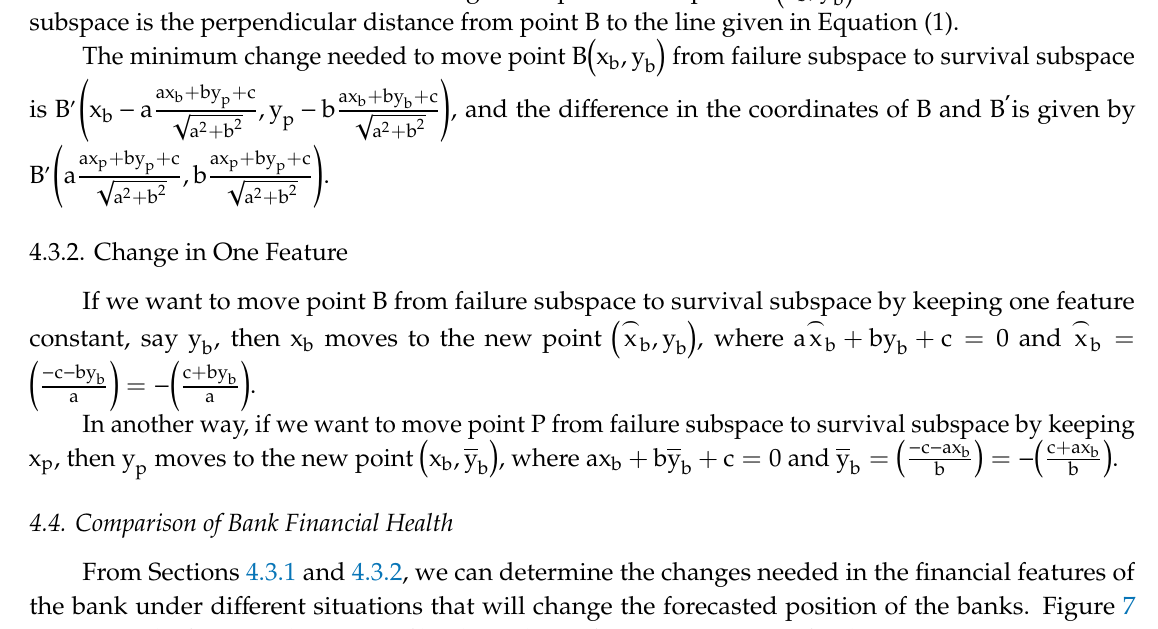
Figure 6. Representation of stress quantification. The x-axis denotes the provision_for_loan_Interest_income(t − 1) and the y-axis represents Tier1CAR(t − 1).